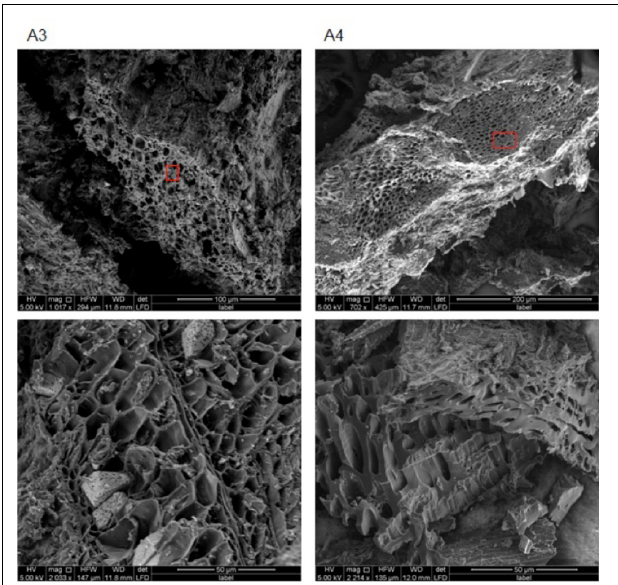
FIGURE 6 | Environmental scanning electron microscopy images of biochars A3 (2 left) and A4 (2 right) at different magnifications (see figure bottom and white bar bottom right). All images were acquired with electron beam at 5 KV and a working distance between 11.9 and 12 mm. Red rectangles indicate the areas from which the EDX spectra in Figure 8 were acquired.